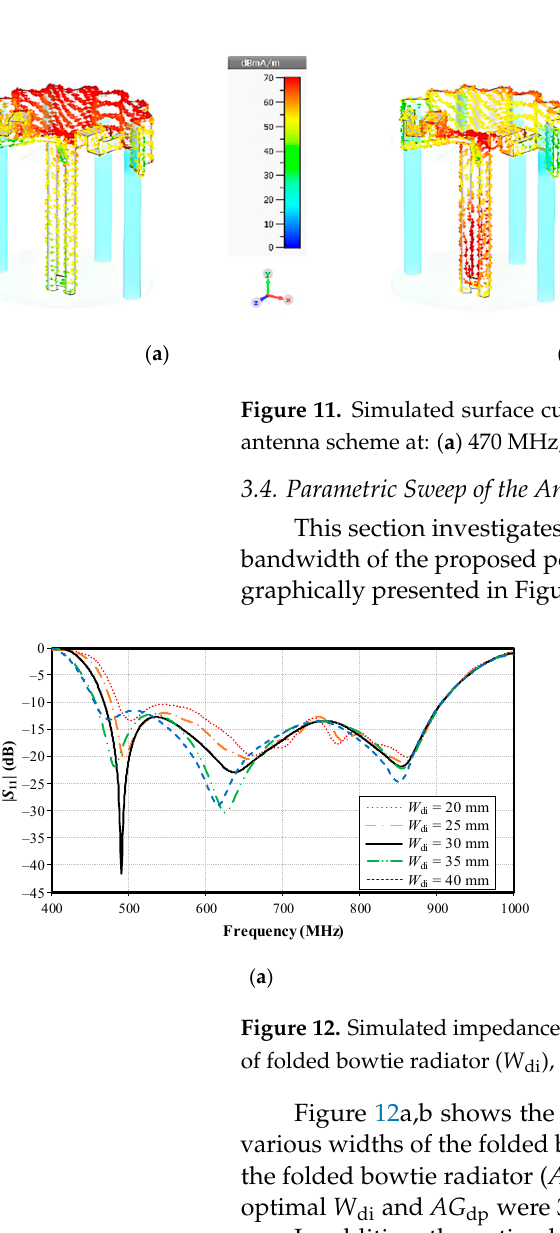
Figure 13. Simulated impedance bandwidth under variable parameters: ( a ) distance from center of the supporting plate to the reflector ( D ref ), ( b ) reflector length ( L ref ), ( c ) reflector height ( h ref ), and ( d ) radiation pattern at 890 MHz under variable h ref .